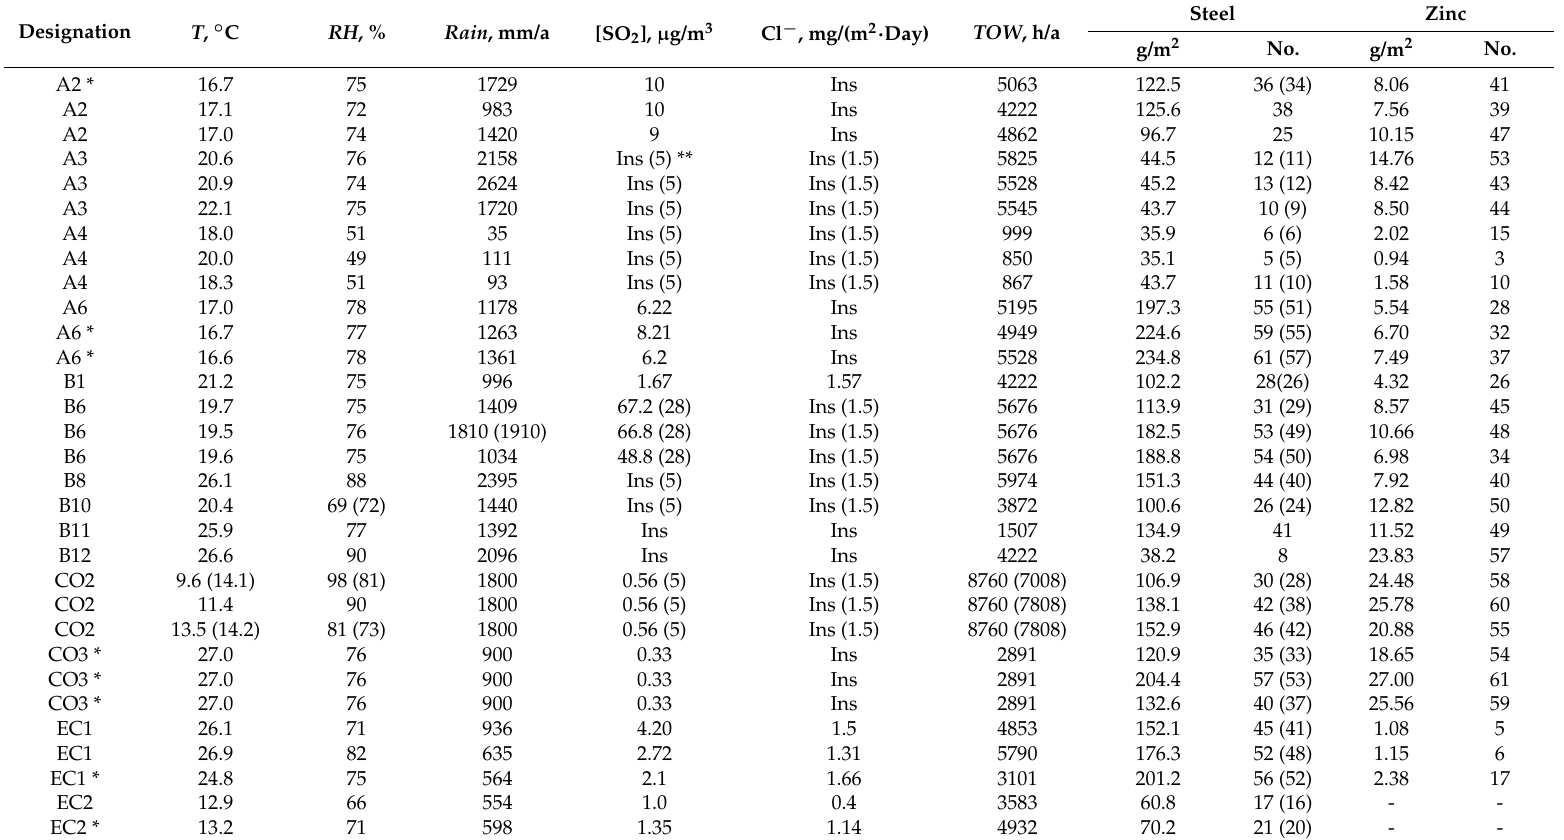
Table 3. Atmosphere corrosivity parameters of test locations, first-year corrosion losses of carbon steel and zinc ( K 1 , g/m 2 ) under the MICAT program and those reported in [20], and numbers of test locations in the order of increasing K 1 . Adapted from [20], with permission from © 2000